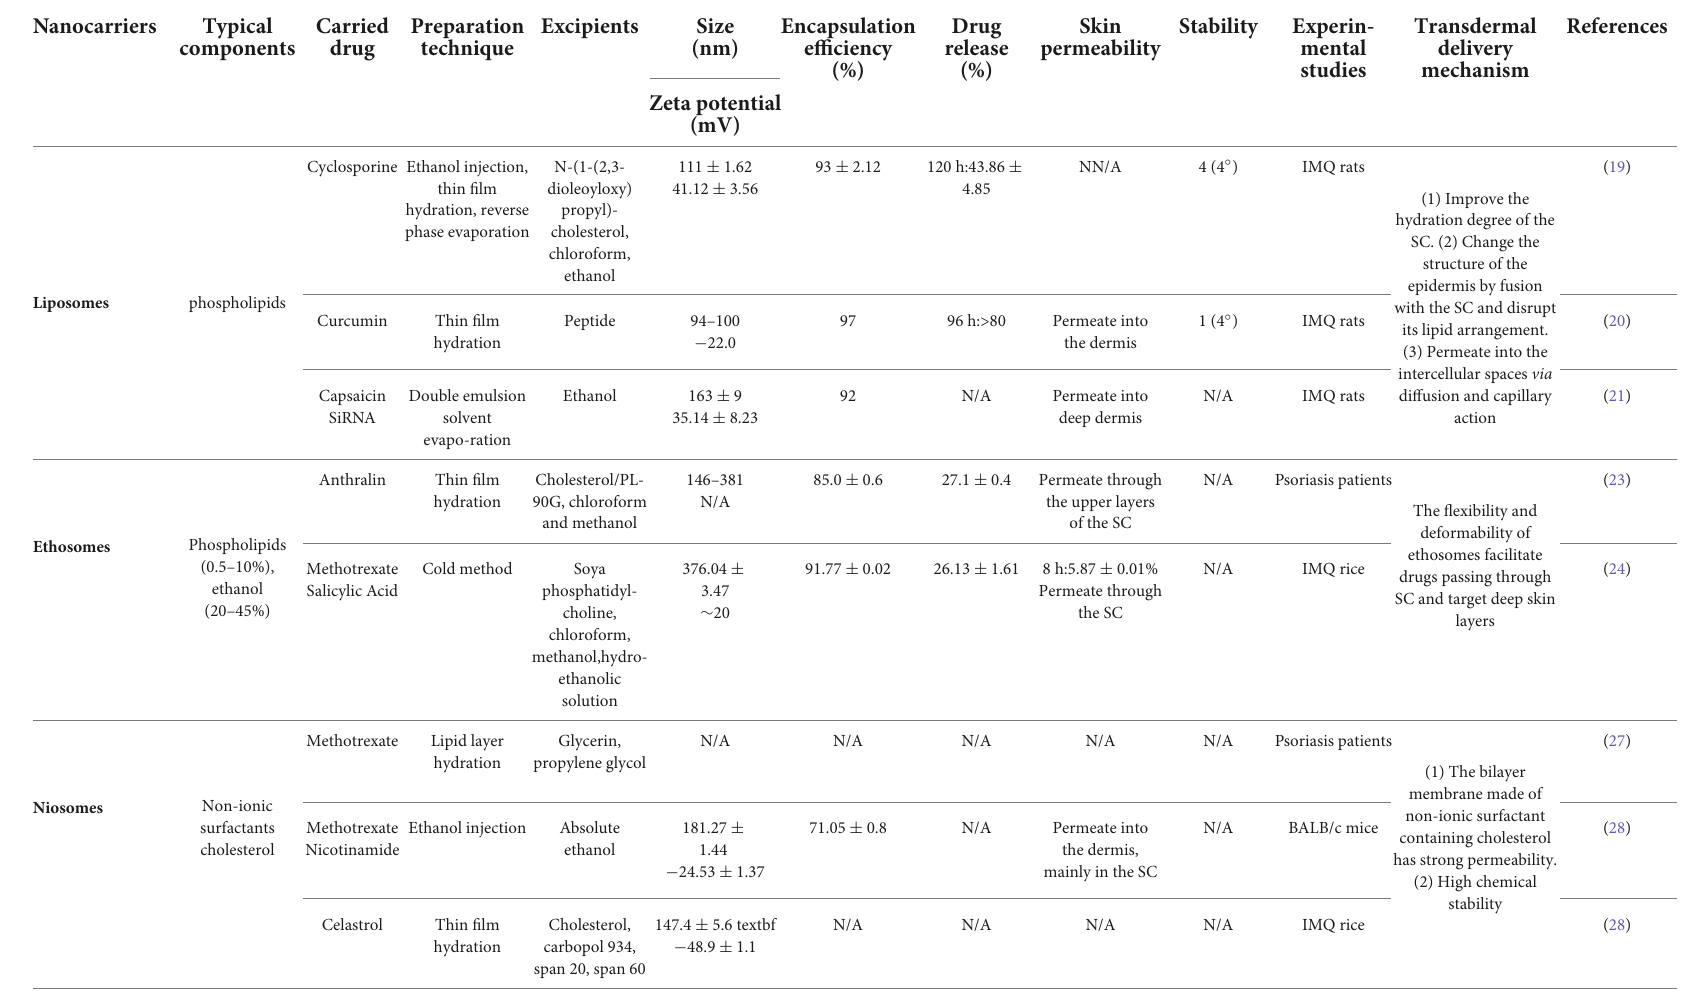
TABLE 2 Topical applications of nanocarriers in drug delivery for psoriasis